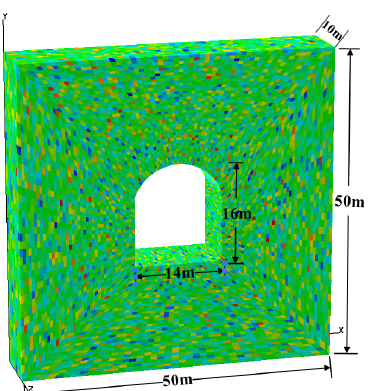
Table 1. Mechanical parameters of the rock mass. Elastic Modulus （ GPa ）